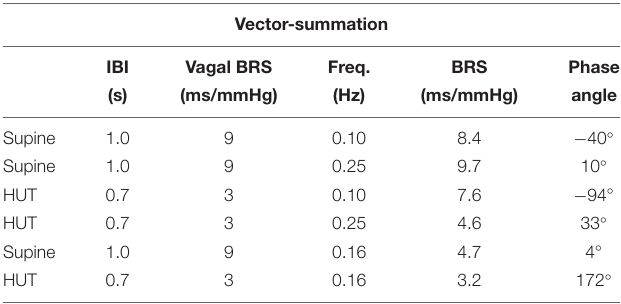
TABLE 2 | Calculated length (BRS) and phase angle of the BRS-vectors, relating the IBI and SAP variations in our simulated data.